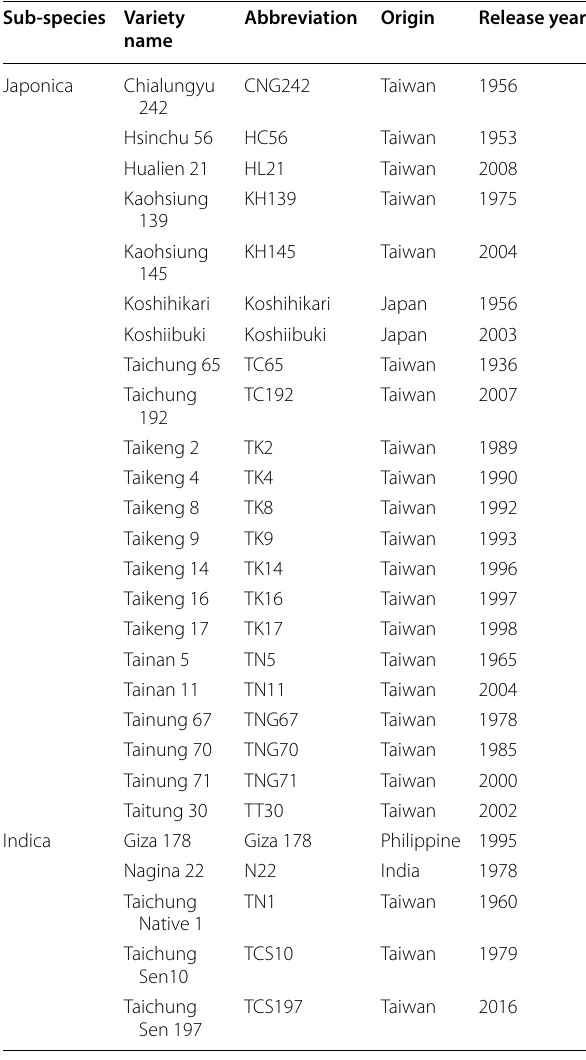
Table 1 List of the rice varieties used in the present